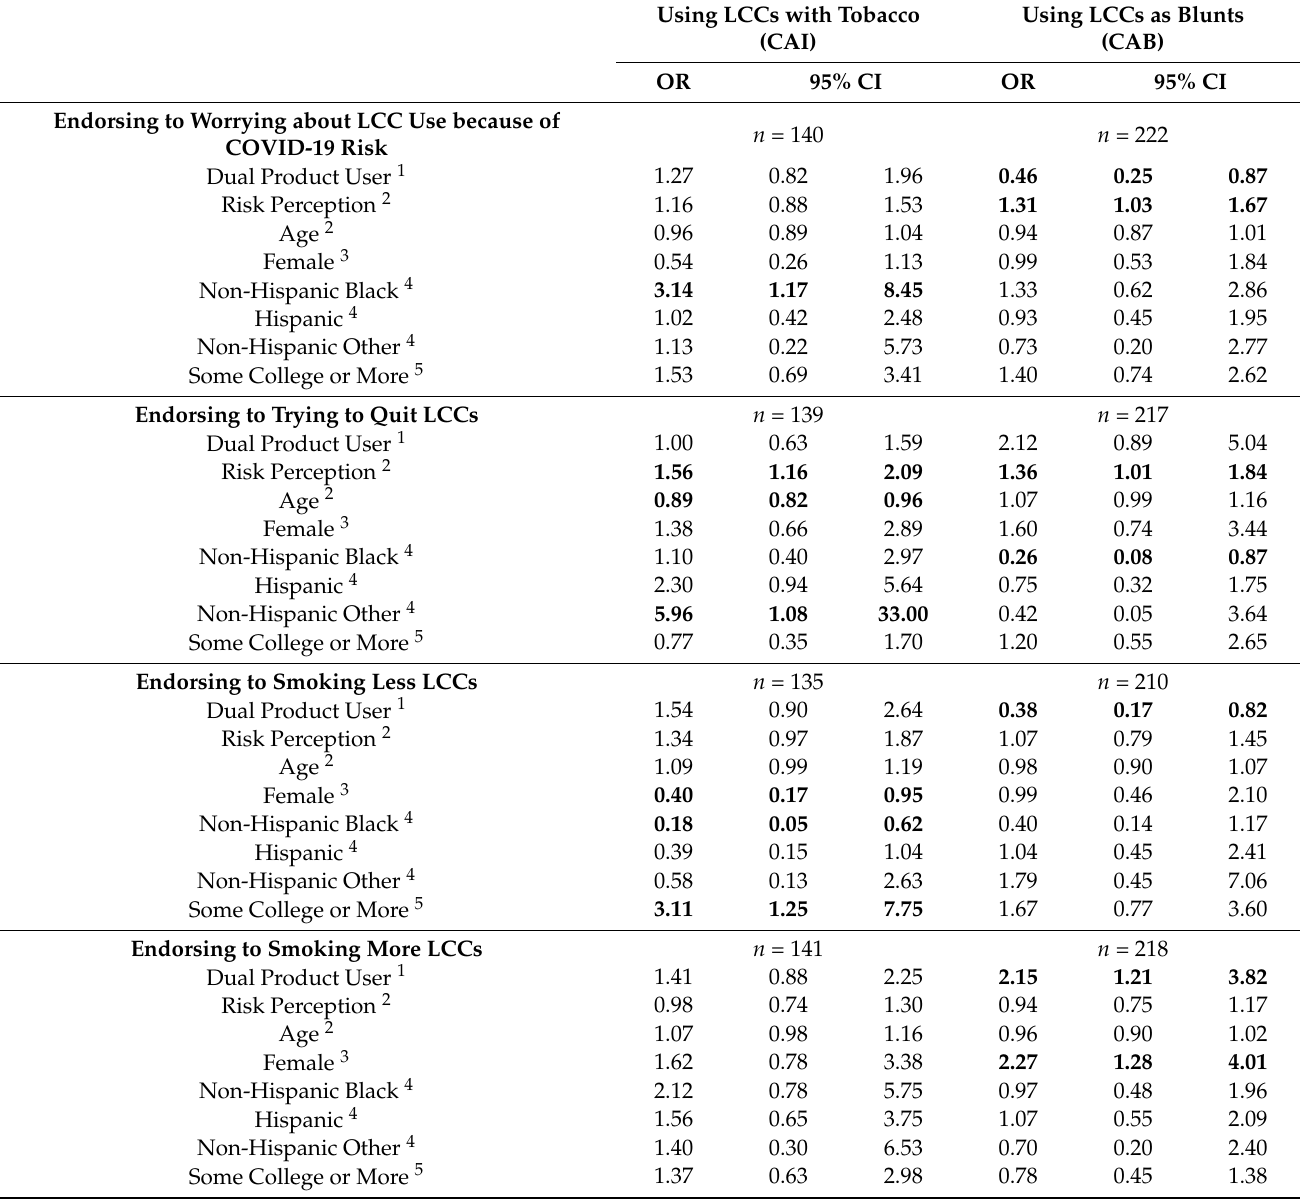
Table 3. Factors associated with behavioral changes in LCC use among past 6 month users. Using LCCs with